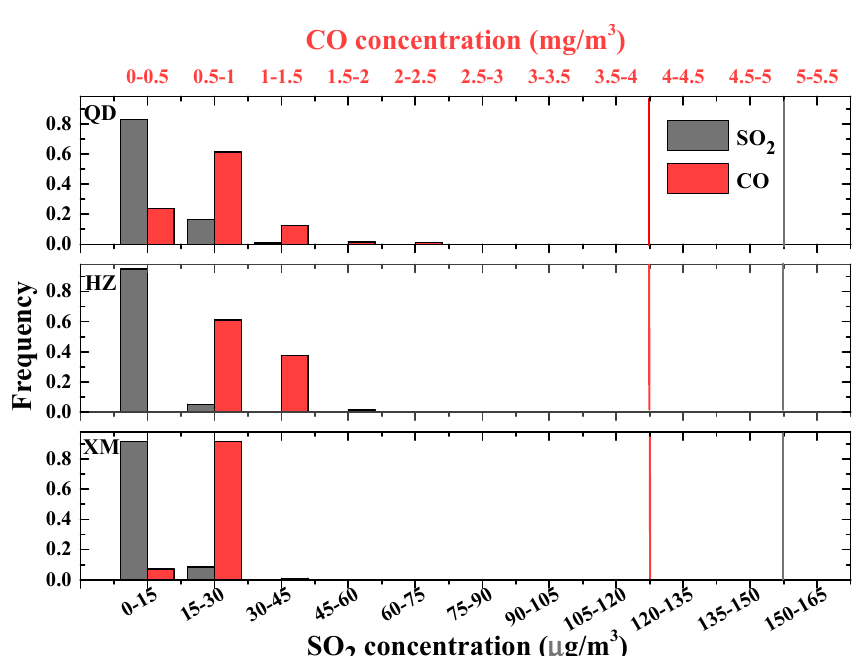
Figure 4. Frequency distributions of daily PM 2.5 and PM 10 in Qingdao (QD), Hangzhou (HZ) and Xiamen (XM) during 2018. The CAAQS Grade II of daily average for PM 2.5 and PM 10 are plotted as solid lines.